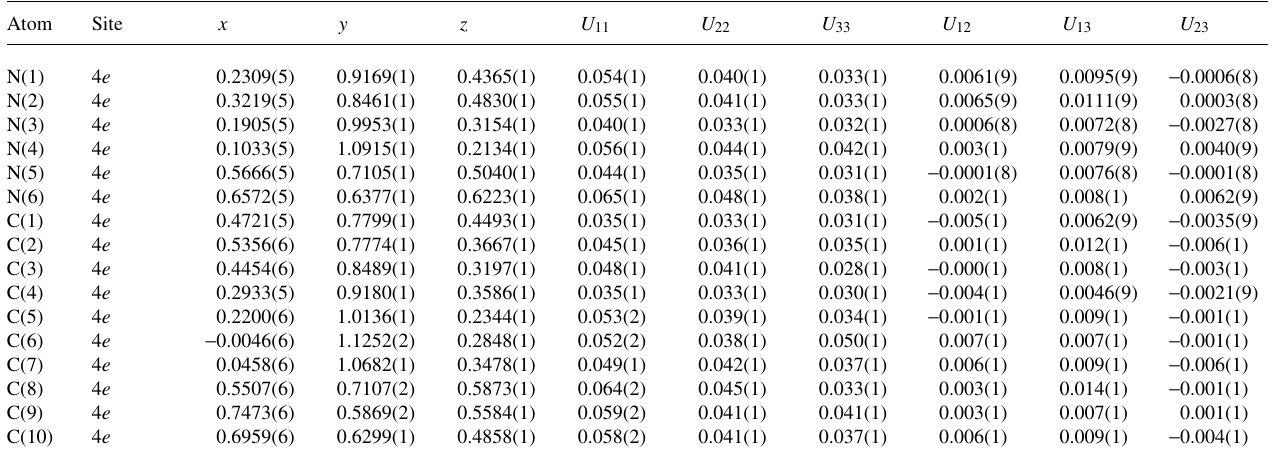
Table 3. Atomic coordinates and displacement parameters (in Å 2 )